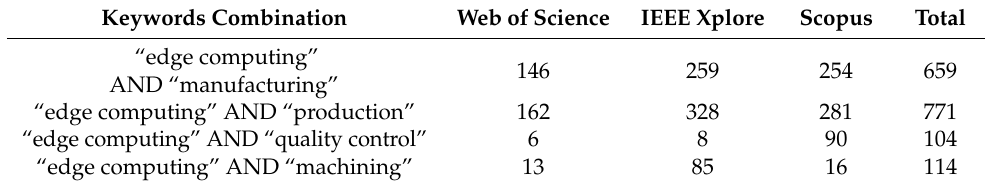
Table 1. Number of results displayed when searching electronic databases.